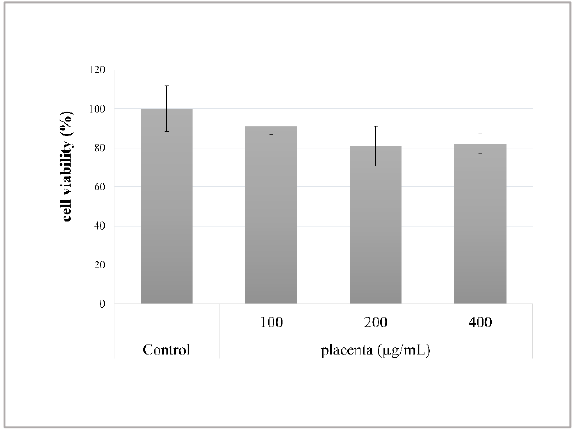
Figure A2. Effect of porcine placenta extract on HaCaT cell viability .